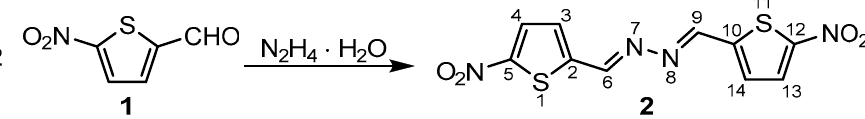
Figure 1. Synthesis of 5-nitro-2-thiophenecarbaldehyde N -(( E )-(5-nitrothienyl)methylidene)hydrazone (KTU-286).